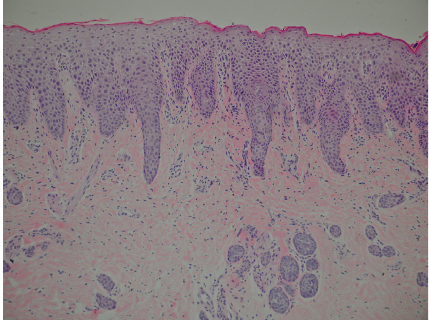
Figure 3: A skin biopsy showing “irregular” acanthosis, para- keratosis, and psoriasiform epidermal